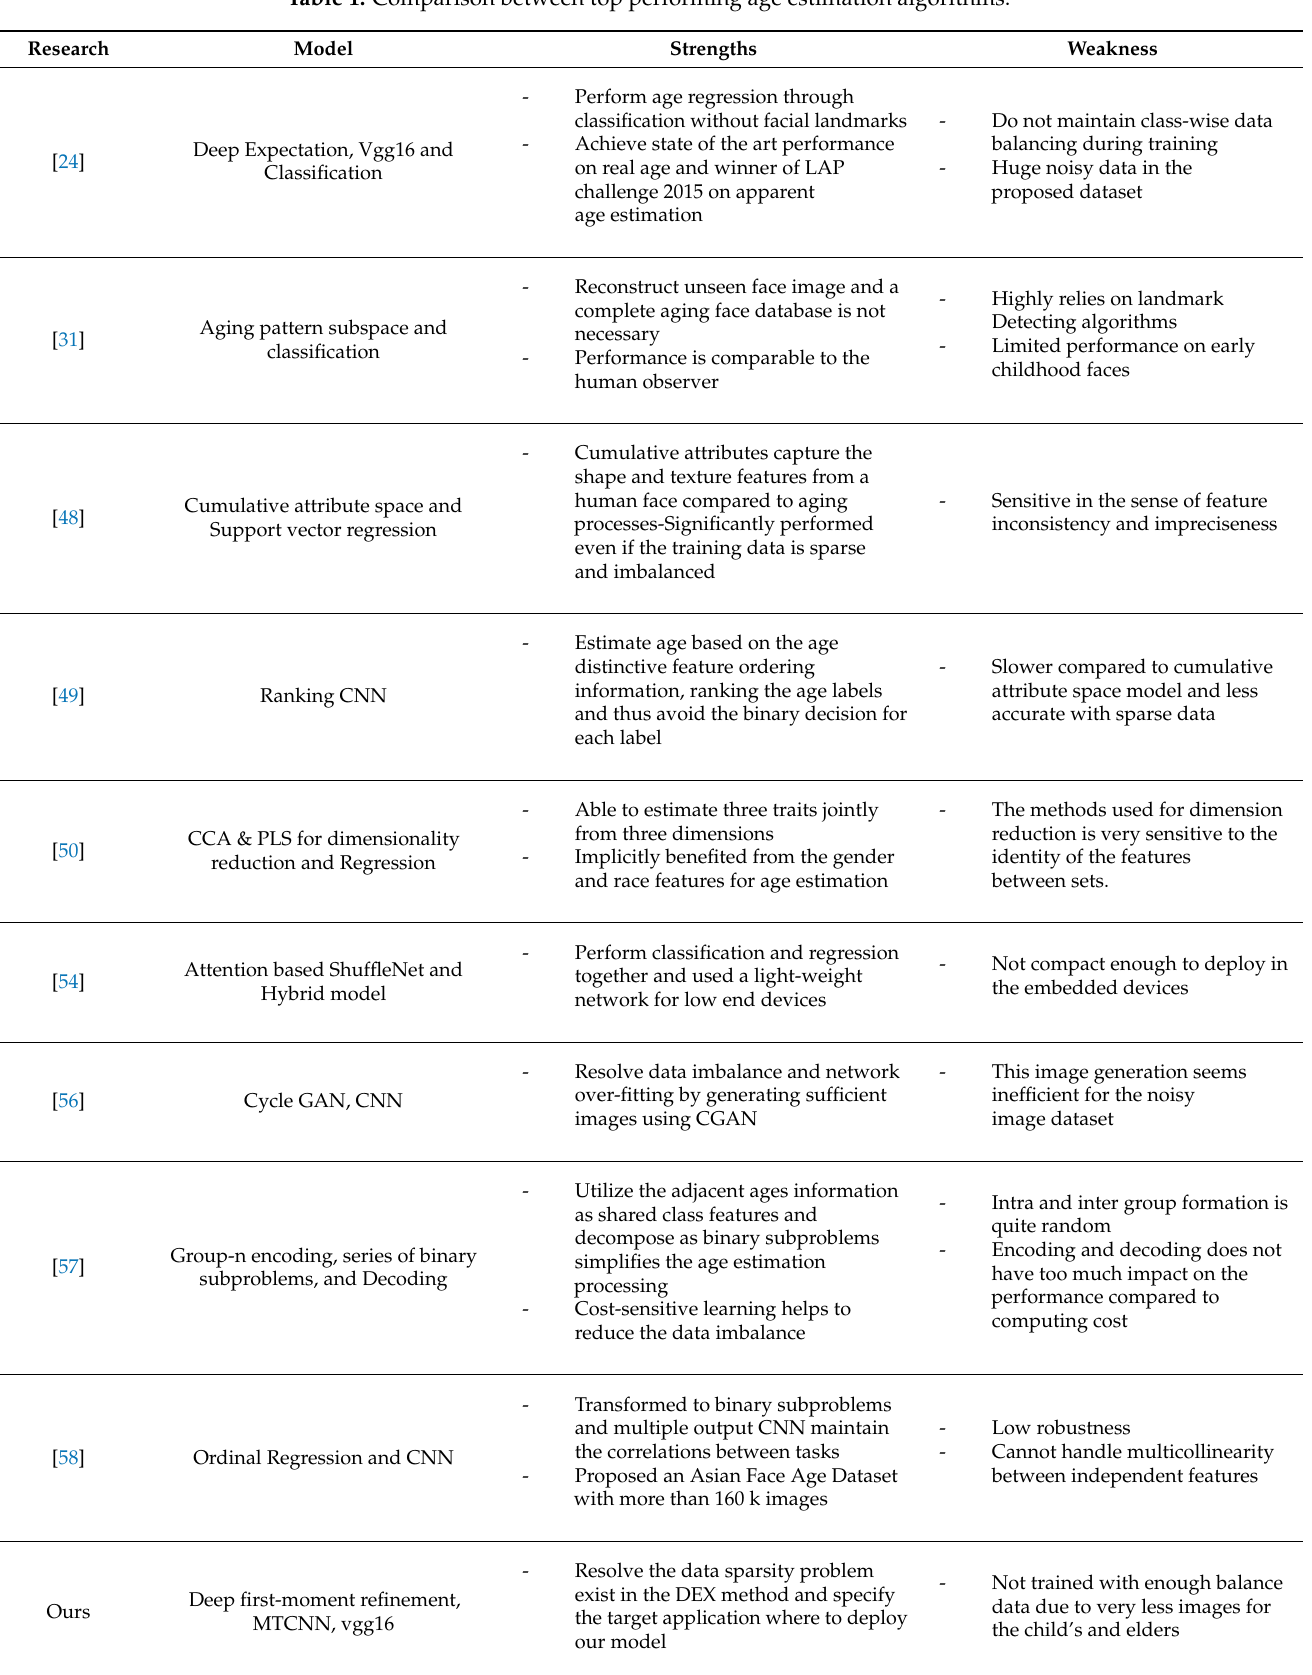
Table 1. Comparison between top performing age estimation